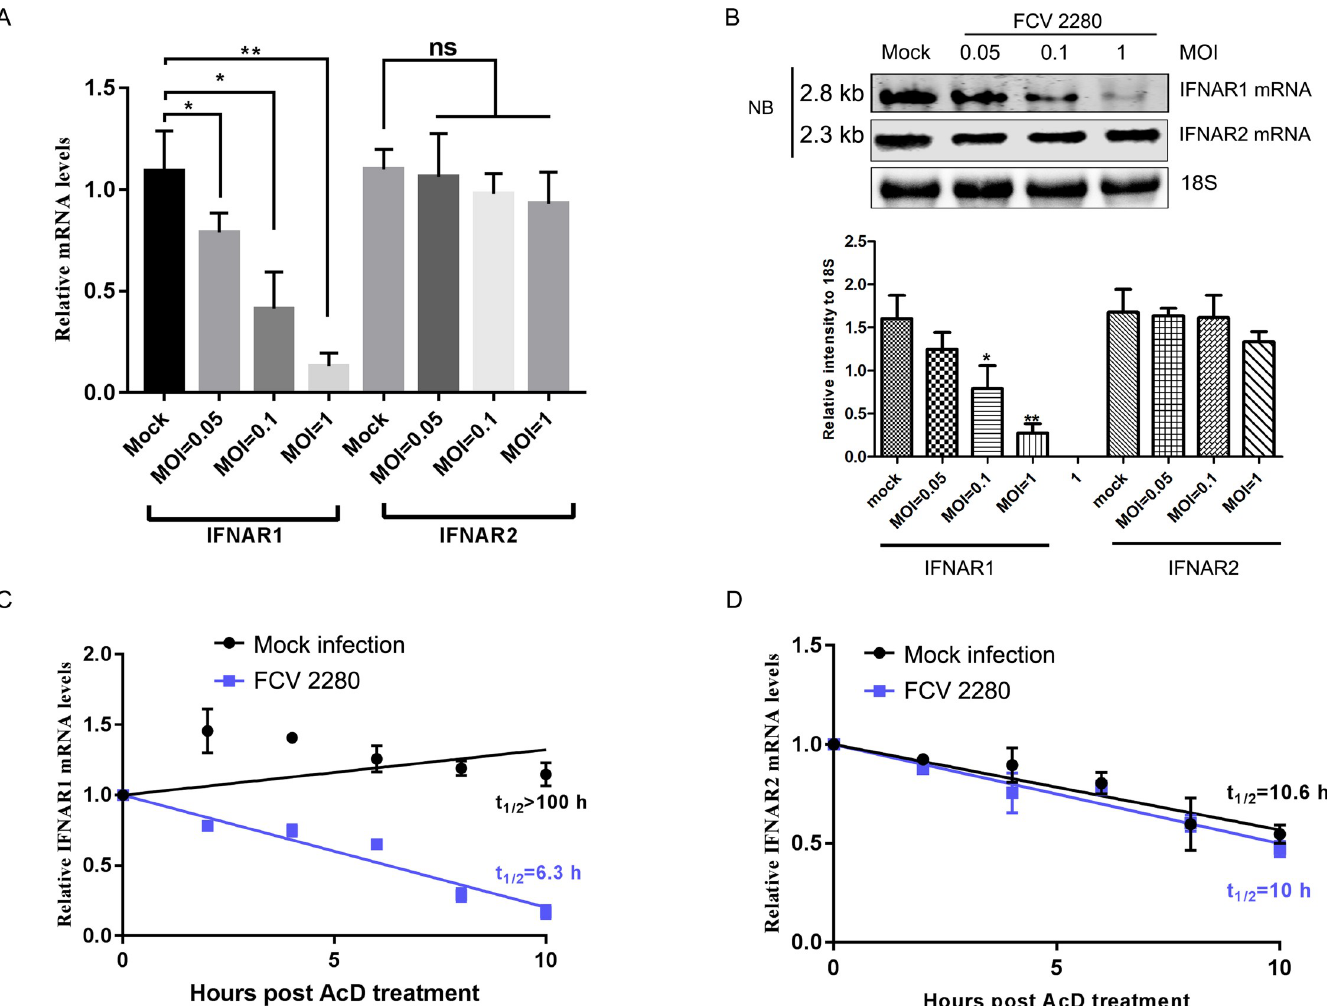
Fig 3. FCV 2280 infection contributes to IFNAR1 mRNA degradation. (A) CRFK cells were mock infected (Mock) or infected with FCV at an MOI of 0.05, 0.1 or 1 for 18 h. Total RNA was extracted. IFNAR1 and IFNAR2 mRNA levels relative to 18S rRNA were assessed by qRT-PCR. (B) CRFK cells were co-transfected with 1 μ g of pcDNA3.1-IFNAR1 and -IFNAR2 for 12 h, and then mock infected (Mock) or infected with different doses of virus for 16 h. Total RNA was extracted for Northern blot (NB) assay. 18S RNA was used as a loading control. (C, D) CRFK cells were mock infected (Mock) or infected with FCV at an MOI of 1. At 30 min post-infection, intracellular RNA was extracted (0 h) or 5 μ M Act.D was added to the culture. Total RNA was extracted at the indicated time points after Act.D addition. qRT-PCR was used to identify the levels of IFNAR1 (C) and IFNAR2 mRNA (D), and the mRNA half-life was calculated. The data in A, C, D represent the mean ± SD for three repeats, and all experiments A-D were repeated three times. Blots shown in B are representative of three independent experiments, and relative intensity levels were quantified using the ImageJ software. Differences ( � p < 0.05, �� p < 0.01, ��� p < 0.001) between the experimental and control groups are noted.